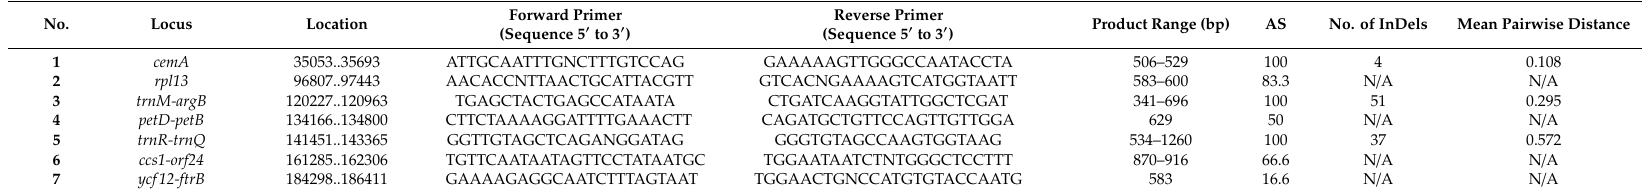
Table 3. Primers for amplifying and sequencing seven highly variable